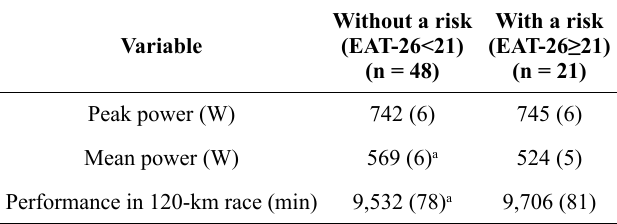
Table 2 Mean and standard error of peak power, mean power and performance in 120-km race according to the dichotomous classifica - tions of the